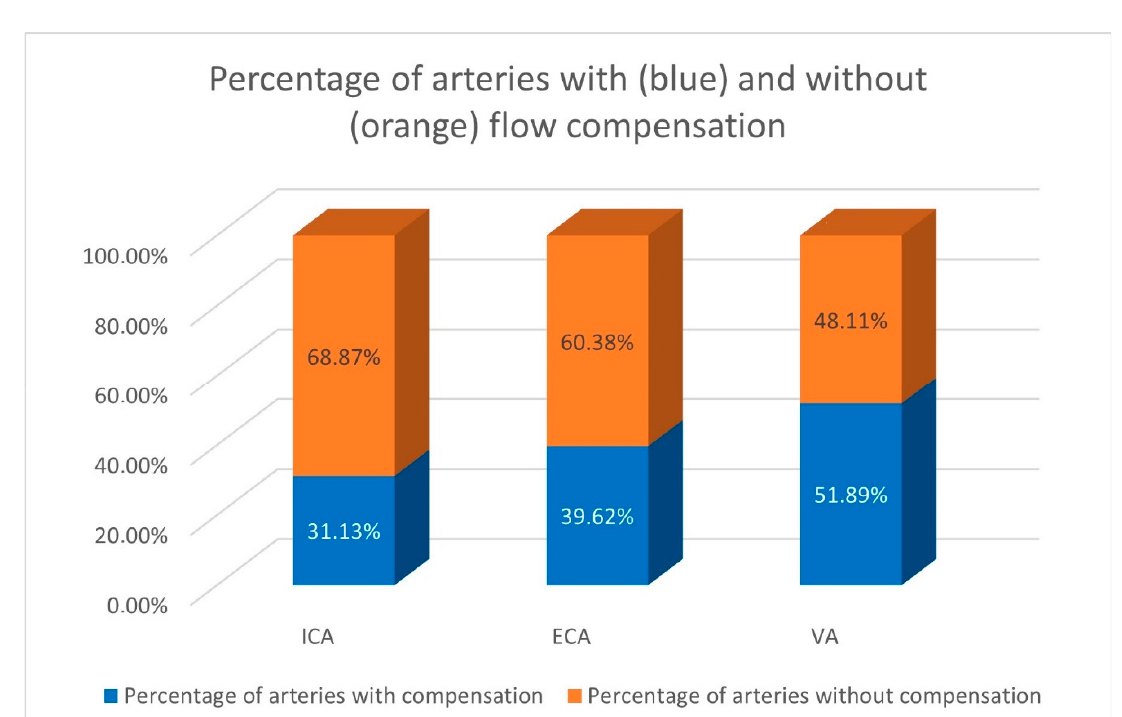
Table 6. Pathways of collateral circulation in patients with bilateral ICA stenosis.